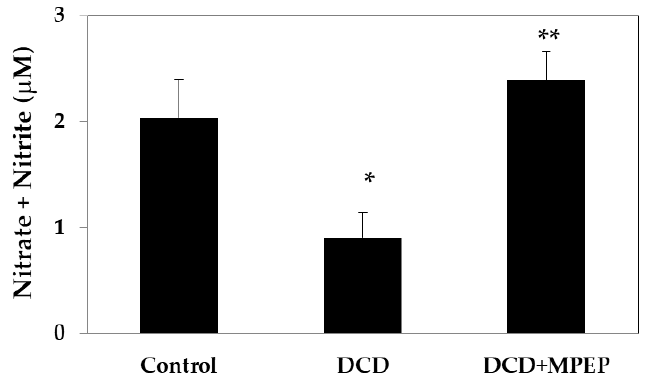
Figure 2. MPEP treatment increases nitrate plus nitrite (NOx) levels in DCD livers during cold storage (22 h in UW solution). Control animals underwent cold storage; in the DCD group, the livers, after 30 min warm ischemia, were submitted to cold storage. In the DCD-MPEP group, the drug (10 mg/Kg) was administered 30 min before the portal clamping and added to the UW-solution (3 µM). The results are reported as the mean ±SE. * p < 0.05 versus control; ** p < 0.05 versus DCD.